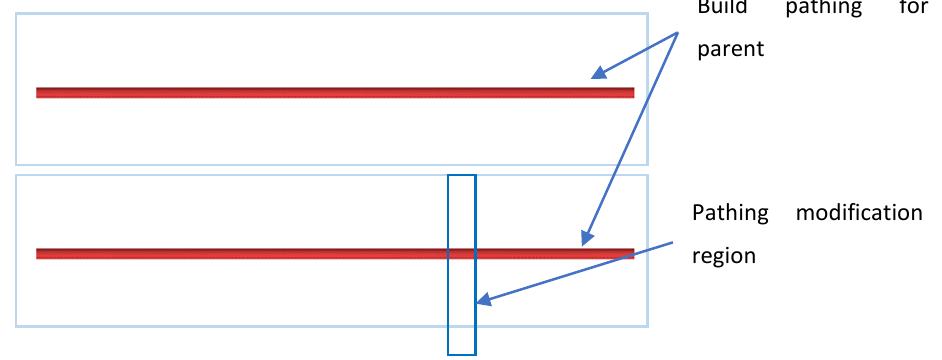
Figure 4. Resultant pathing. The red paths represent the build paths of the wall (parent).